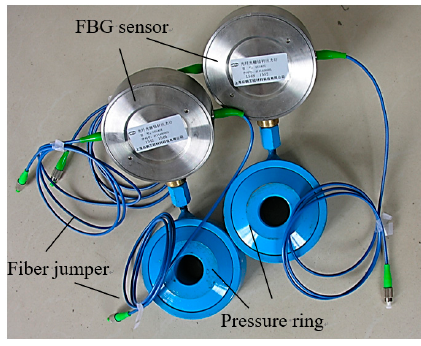
Figure 7. Two packaged FBG stress sensors.